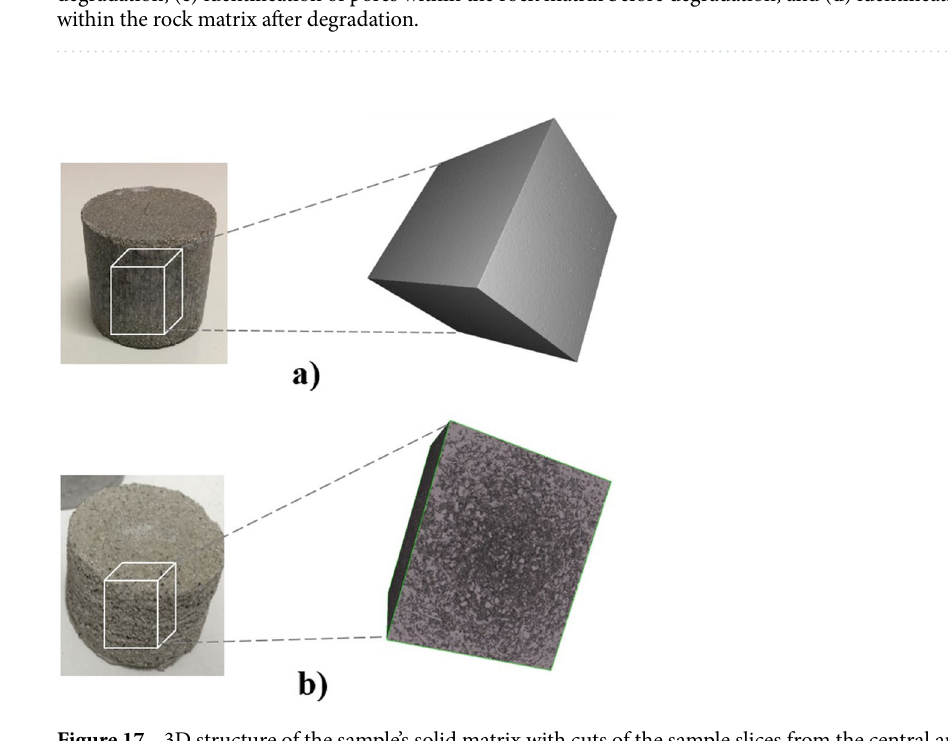
Figure 17. 3D structure of the sample’s solid matrix with cuts of the sample slices from the central area ( a ) before degradation and ( b ) after